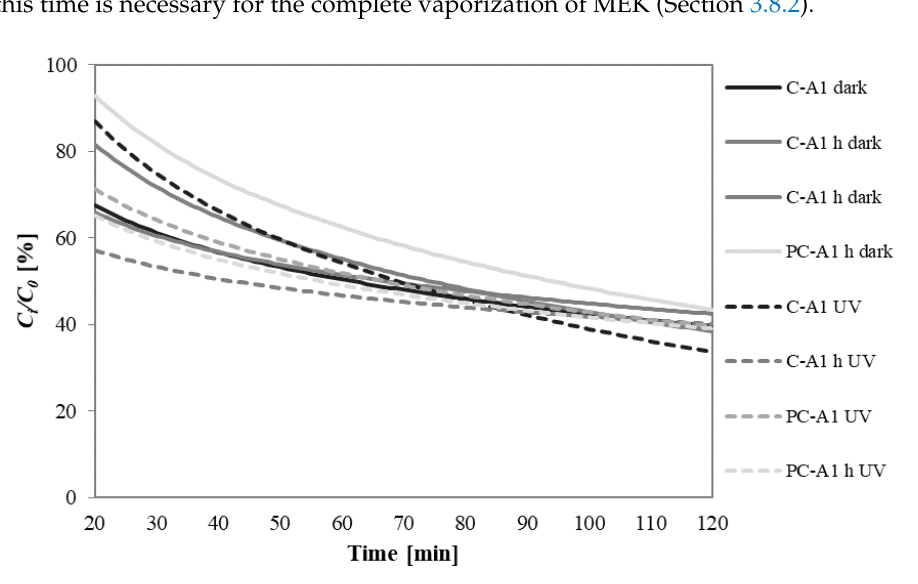
Figure 12. Methyl-ethyl-ketone (MEK) residual concentration inside the box as a function of time under dark conditions and under UVA radiation: A1 mortar.